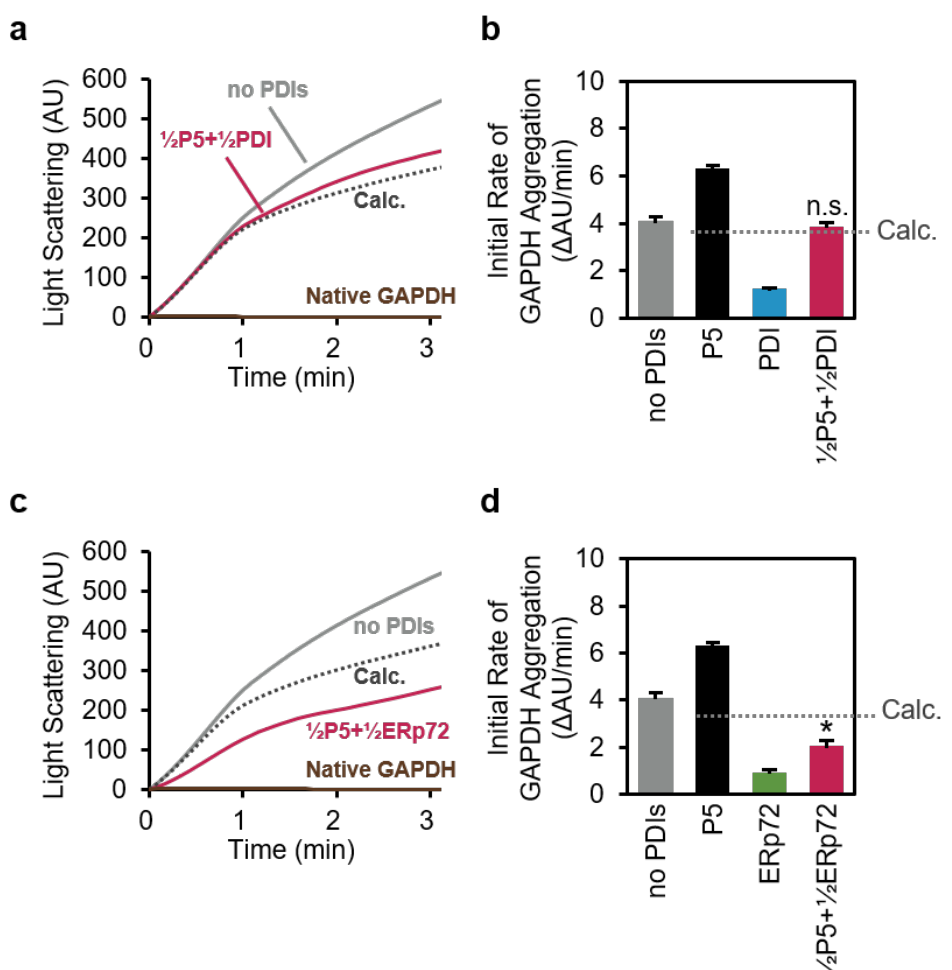
Figure 4. P5 acts in concert with ERp72 to strongly inhibit client aggregation. ( a , c ) Reduced and denatured GAPDH (1 µM) was incubated without PDIs ( no PDIs ), with 2.5 µM P5 and 2.5 µM PDI ( ½P5+½PDI ), or with 2.5 µM P5 and 2.5 µM ERp72 ( ½P5+½ERp72 ), and GAPDH aggregation was evaluated by measuring 90° light scattering at 620 nm over time. As a control, folded and non-reduced GAPDH ( Native GAPDH ) was also incubated and evaluated. ( b , d ) Comparison of aggregation rates in ( a , c ). The initial rate of GAPDH aggregation was calculated from the increase in fluorescence intensity during the initial 60 sec. Error bars indicate the means ± SEM of three independent experiments. AU, arbitrary units; Calc. , calculated arithmetic means of the initial rates of P5 and PDIs (see Figure S2). *, p < 0.05, statistical significance between the mean of ½P5+½PDI or ½P5+½ERp72 and Calc. by a two-tailed t-test; n.s., no statistical significance.